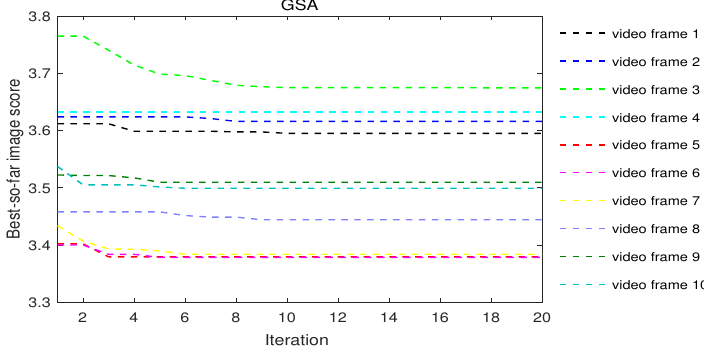
Figure 15. GSA image quality score optimization curve.